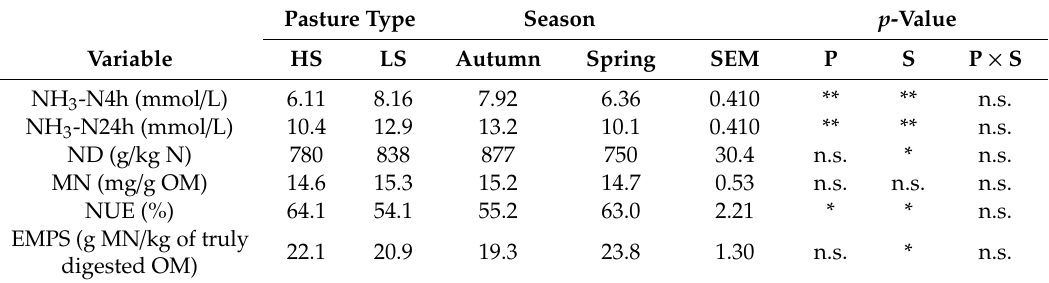
Table 5. E ff ect of pasture type and season on in vitro nitrogen metabolism and e ffi ciency. Pasture Type Season p -Value Variable HS LS Autumn Spring SEM P ×